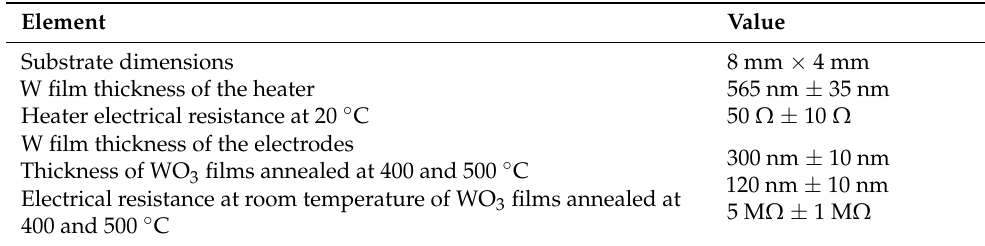
Figure 1. Gas sensor structure [19]. Table 1. Physical and electrical characteristics of the complete sensor: heater and sensing elements [19].